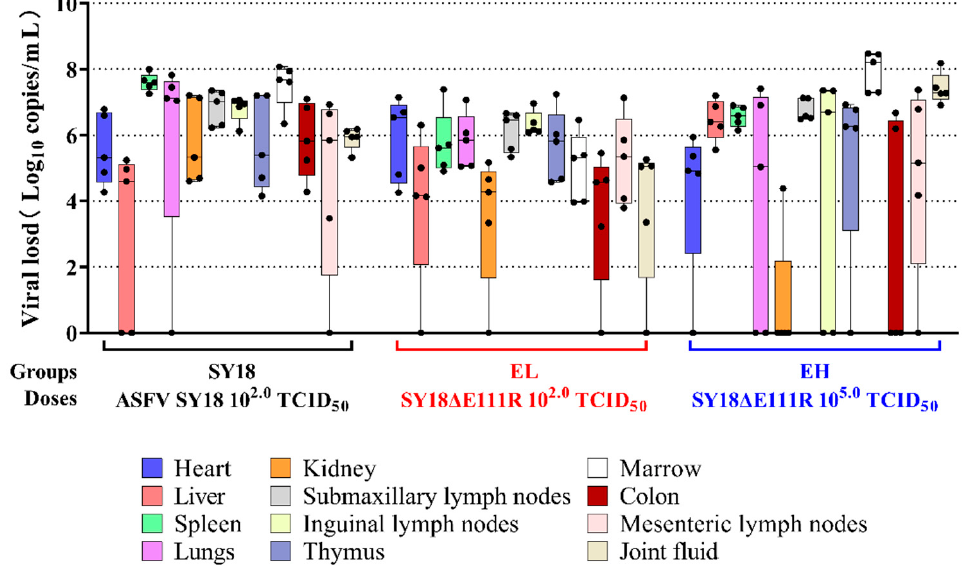
Figure 5. Viral load results for tissues. Black dots represent the viral load of individuals in the tissue.